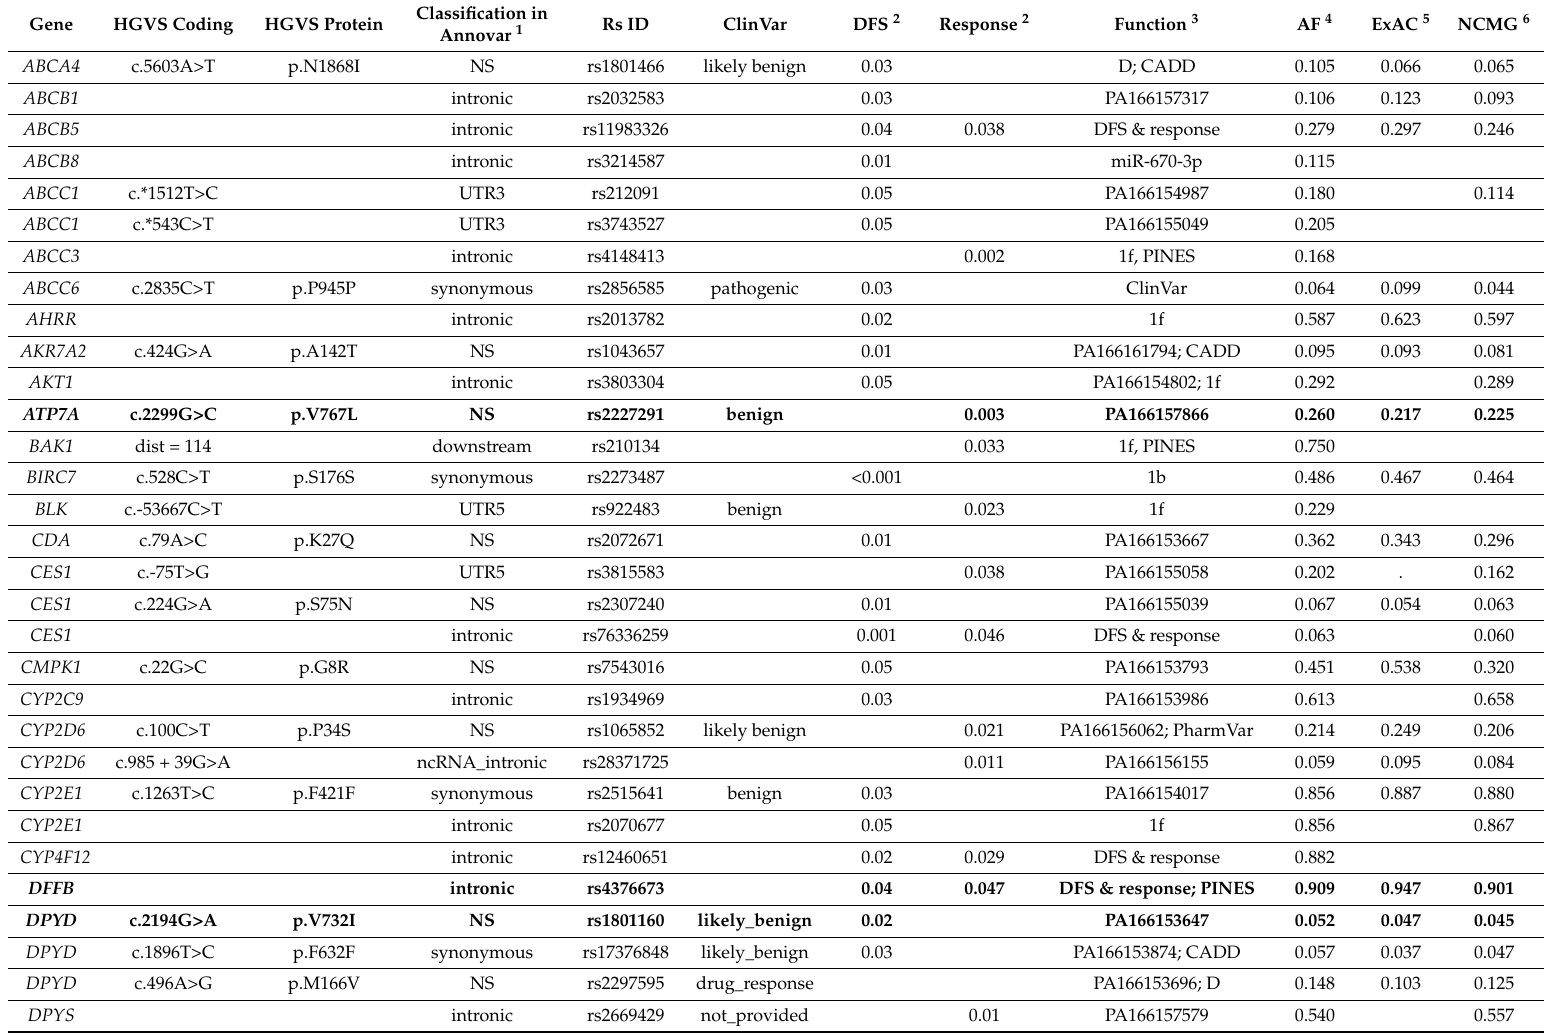
Table 5. Prioritized variants for the validation